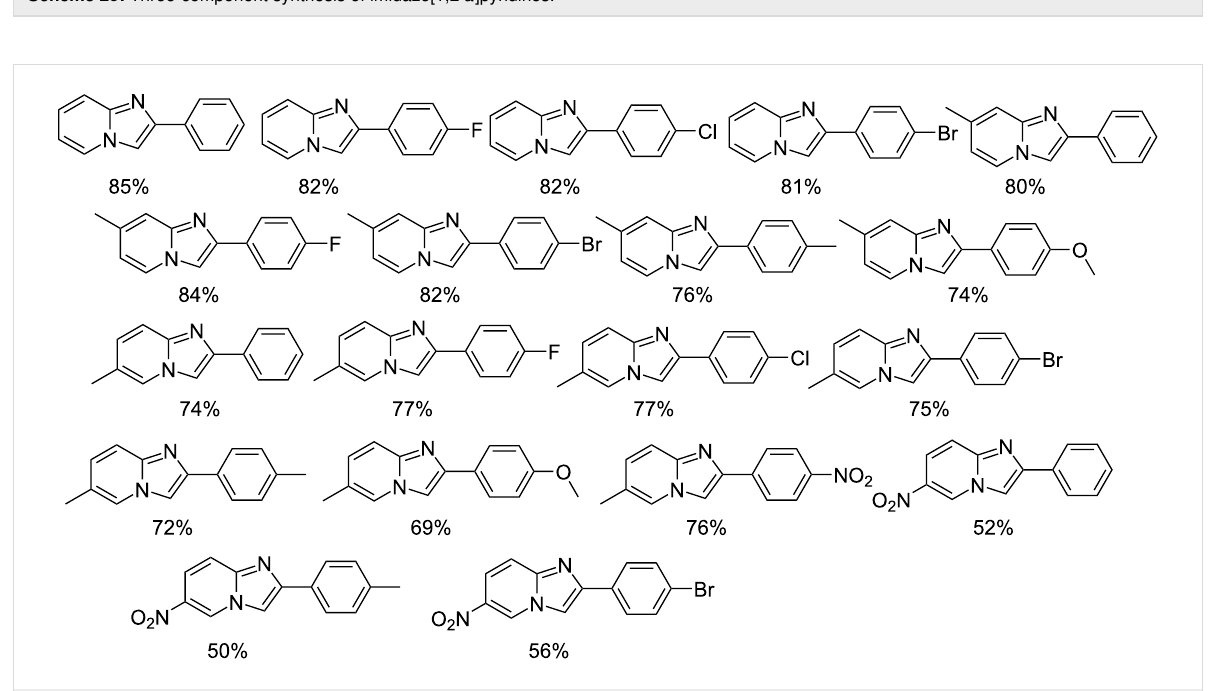
Figure 3: Scope of pyridin-2(1 H )-ones and